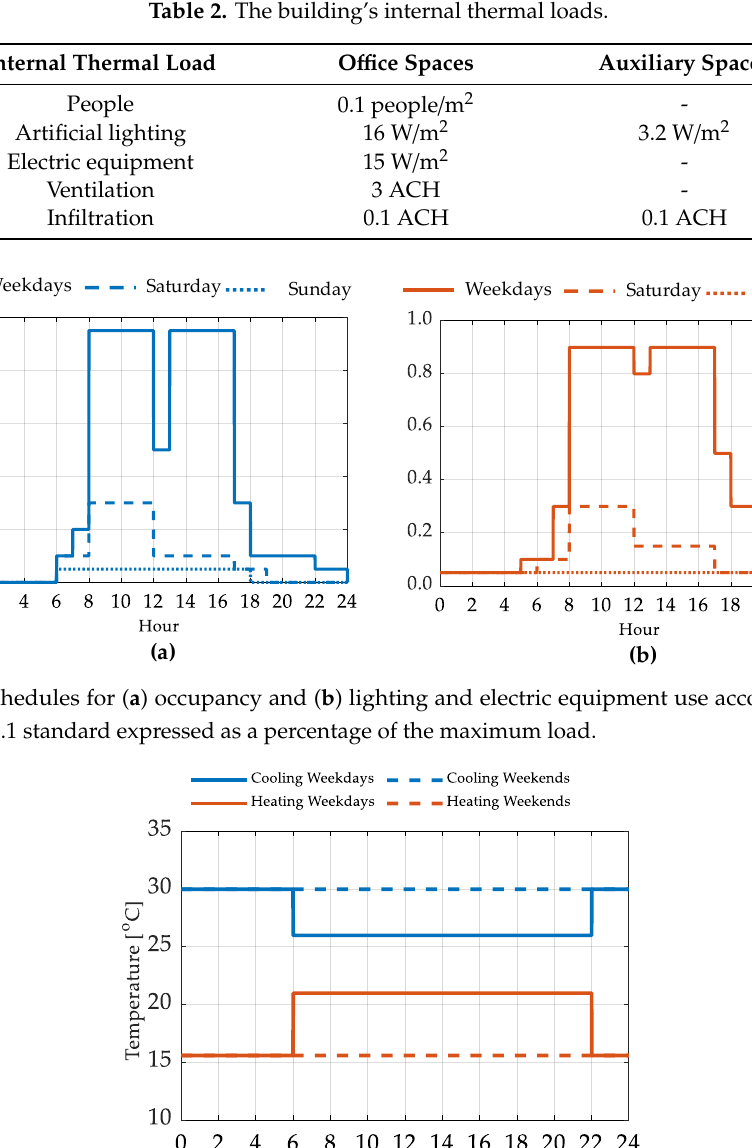
Figure 3. Thermostat setpoints for the office zones.